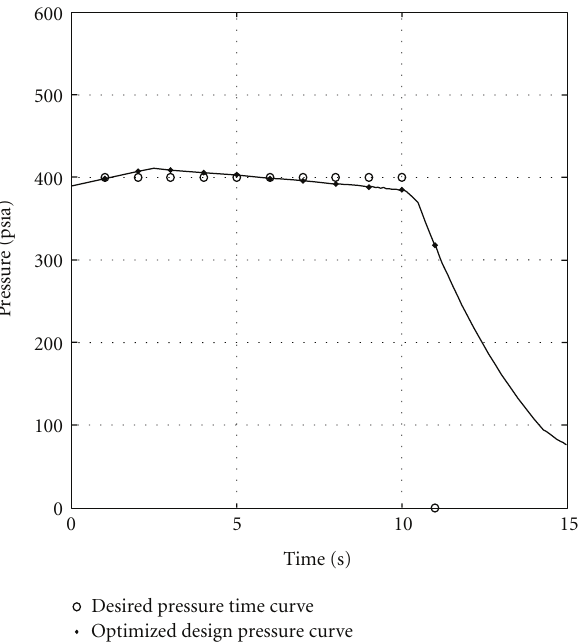
Figure 12: Optimized pressure-time curve for neutral burning CP grain.